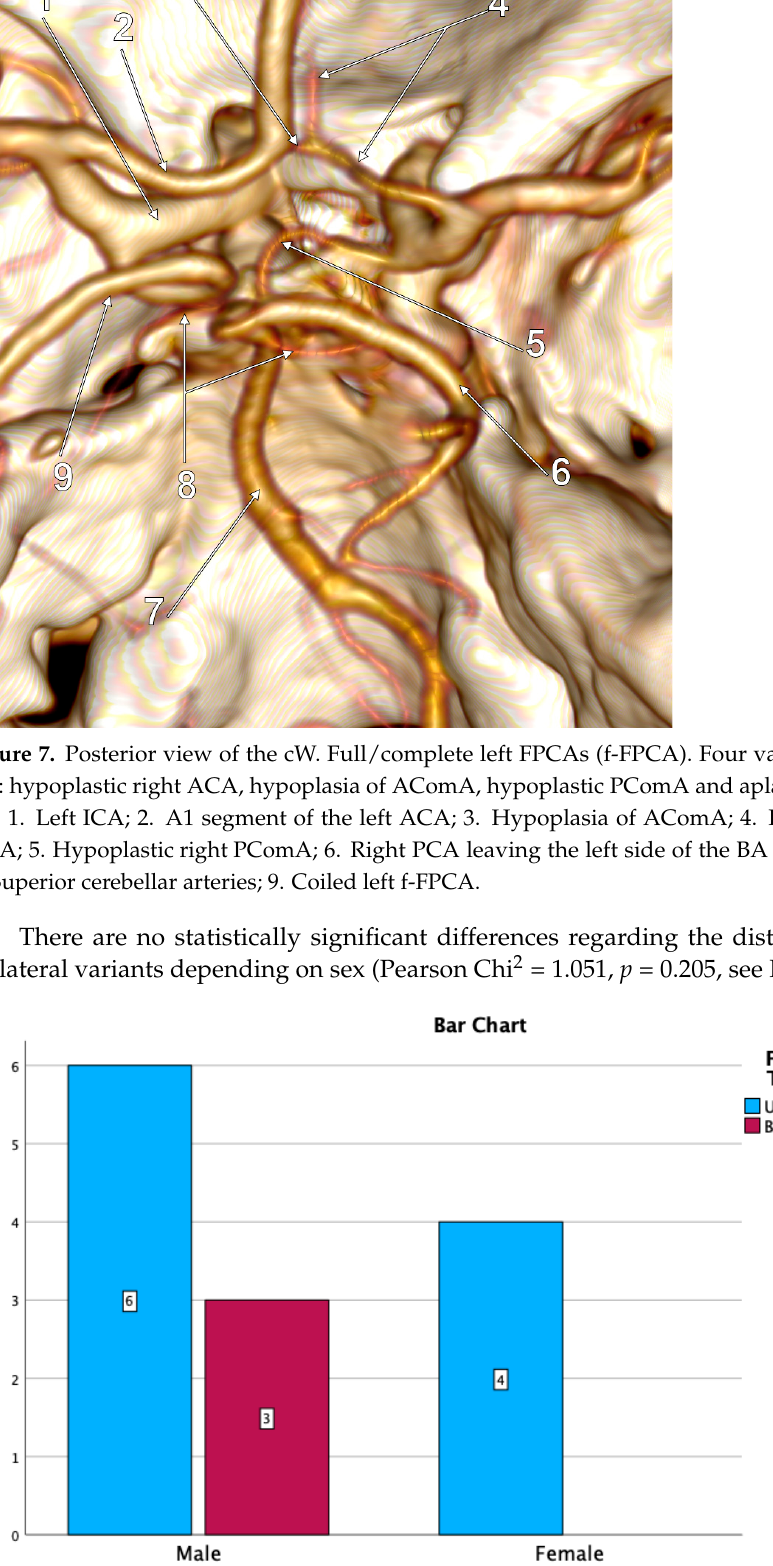
F = 1.091, p = 0.319).